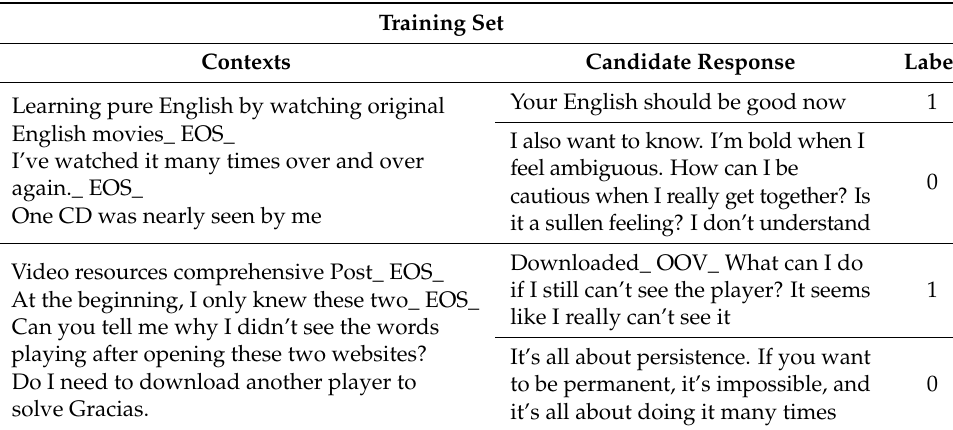
Table 3. Douban Data Set (Chinese Training